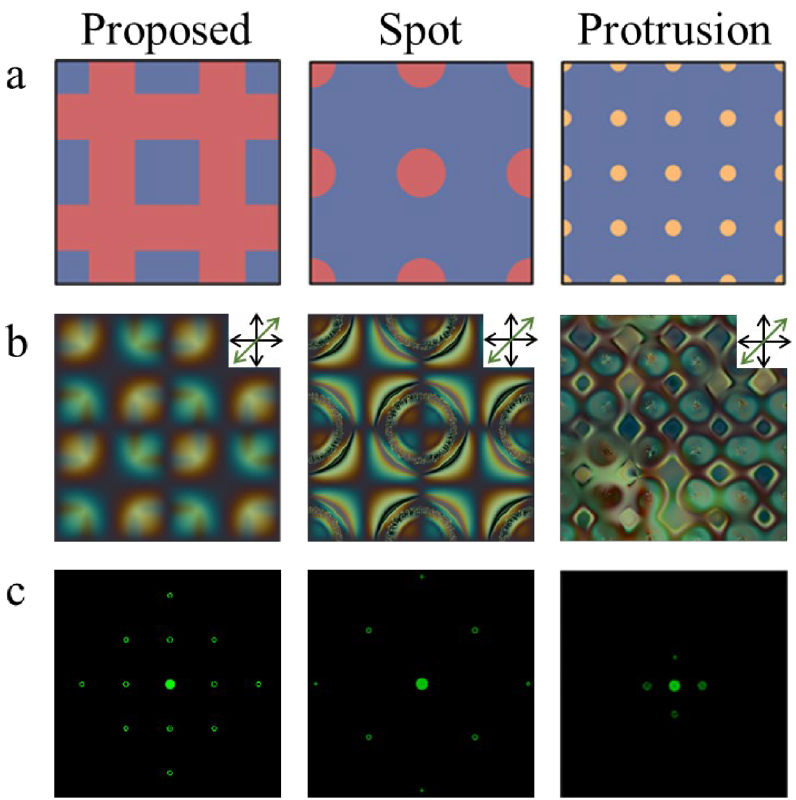
Figure 6. LC grating cells with octothorp and spot patterned electrode and protrusion grating cells without patterned electrode. ( a ) Schematic of the structures; ( b ) POM images; ( c ) Diffraction patterns at maximum haze